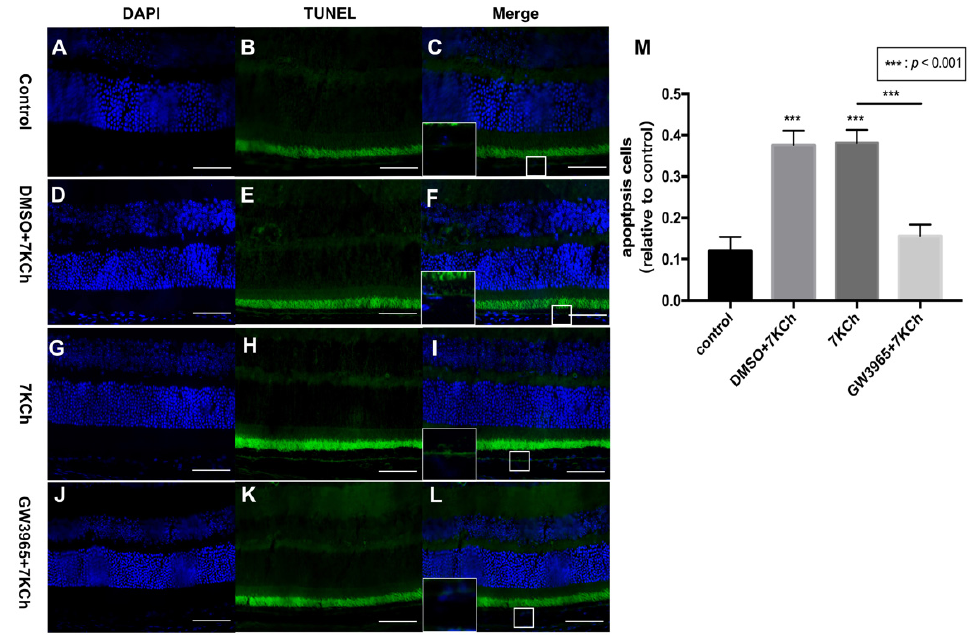
Figure 3. Apoptosis of RPE cells detected by TUNEL assay. ( A – C ) C57BL/6 mice were gavaged saline (100 µ L/10 g) for seven days ( n = 4). ( D – F ) Firstly, C57BL/6 mice were gavaged DMSO (1%) for three days, and then they were subretinally injected 7KCh. After injection, gavaging with DMSO (1%) continued for four days. ( G – I ) C57BL/6 mice were gavaged saline (100 µ L/10 g) for three days, then they were subretinal injected 7KCh. After injection, gavaging with saline (100 µ L/10 g) continued for four days. ( J – L ) C57BL/6 mice were gavaged GW3965 (10 mg/kg) for three days, and then they were subretinally injected 7KCh. After injection, gavaging with GW3965 (10 mg/kg) continued for four days. Retinas were harvested, sectioned, and subjected to TUNEL analyses. Blue represents nuclei, and the green represents apoptosis cells. Scale bar 50 µ m. ( M ) Fluorescent intensity was measured at eight different locations and averaged. Data are represented as mean ± SEM of three independent experiments. Differences of p < 0.05 were considered statistically significant.